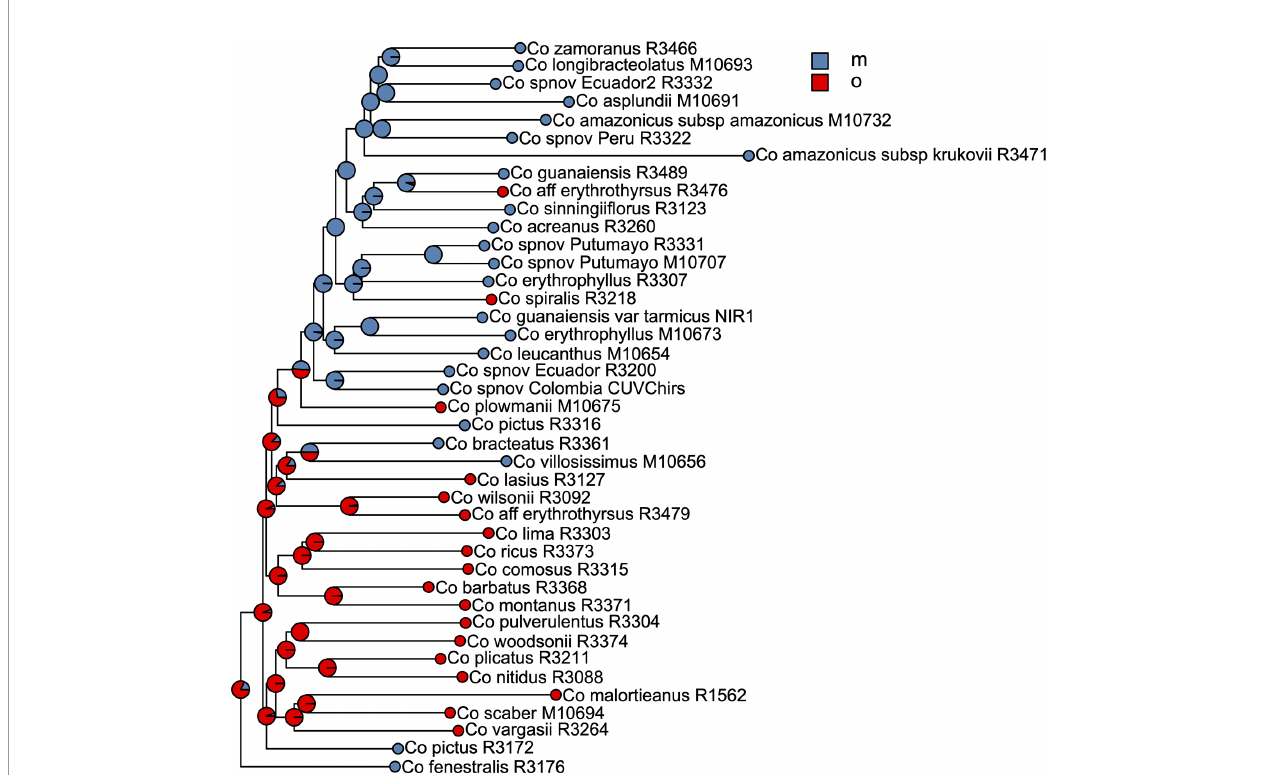
FIGURE 7 | Summary of the stochastic character mapping showing multiple shifts in pollination syndromes during the history of the Neotropical Costus . Pie charts indicate the posterior probabilities obtained from the 1,000 stochastic mappings (m, melittophilous; o, ornithophilous).